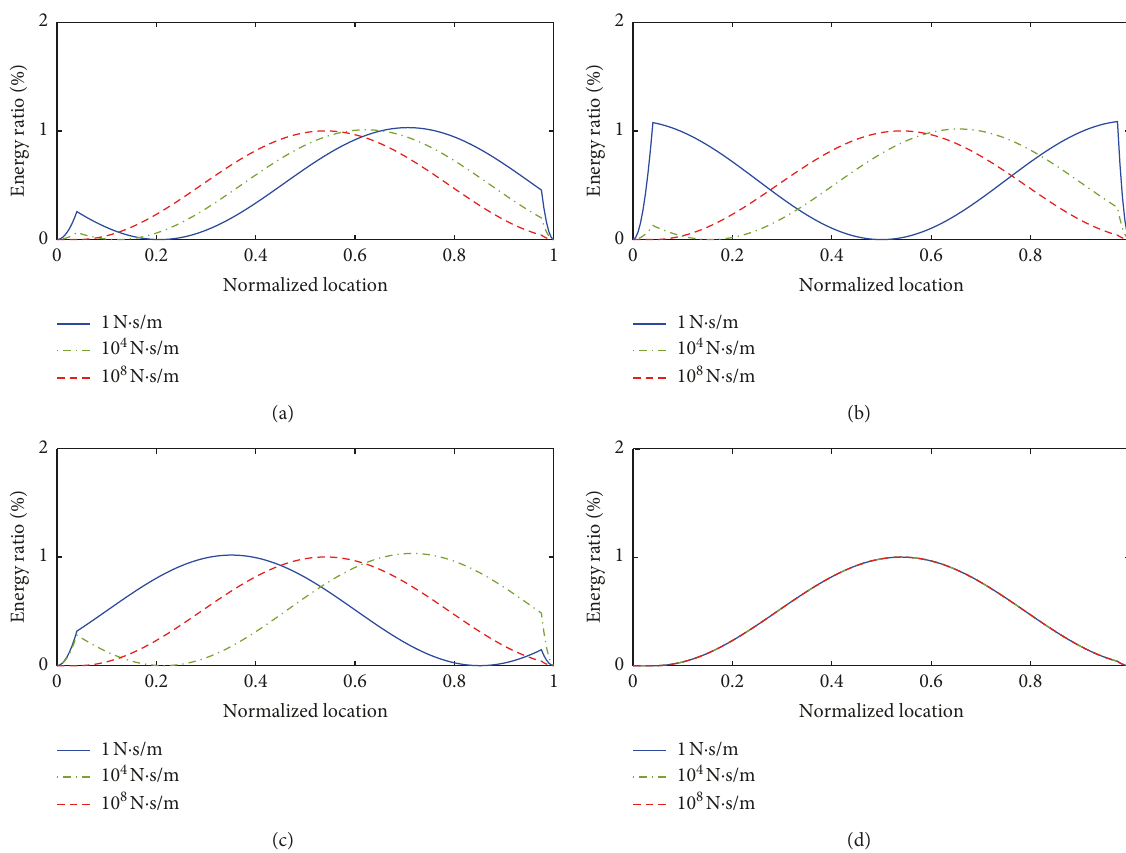
Figure 17: Distribution of the cable mechanical energy under the first modal vibration: (a) k | � − 0 . 8; (d) k / | k opt (c) k d d